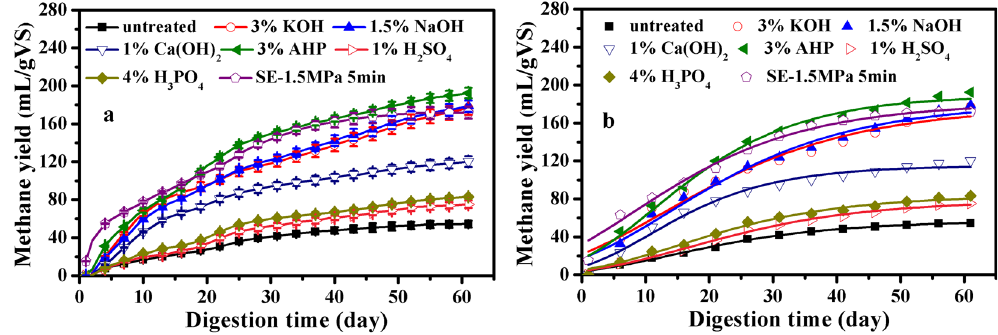
Figure 2. The optimal results and kinetics of methane yield after seven pretreatments.